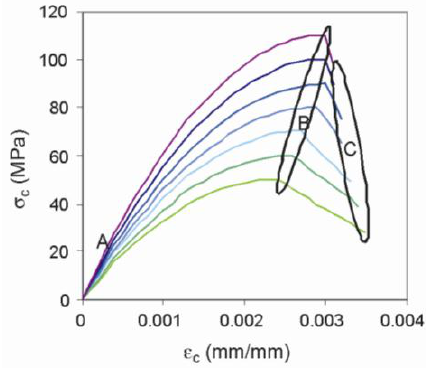
Fig. 1. Typical uniaxial stress-strain relationships for unconfi- ned